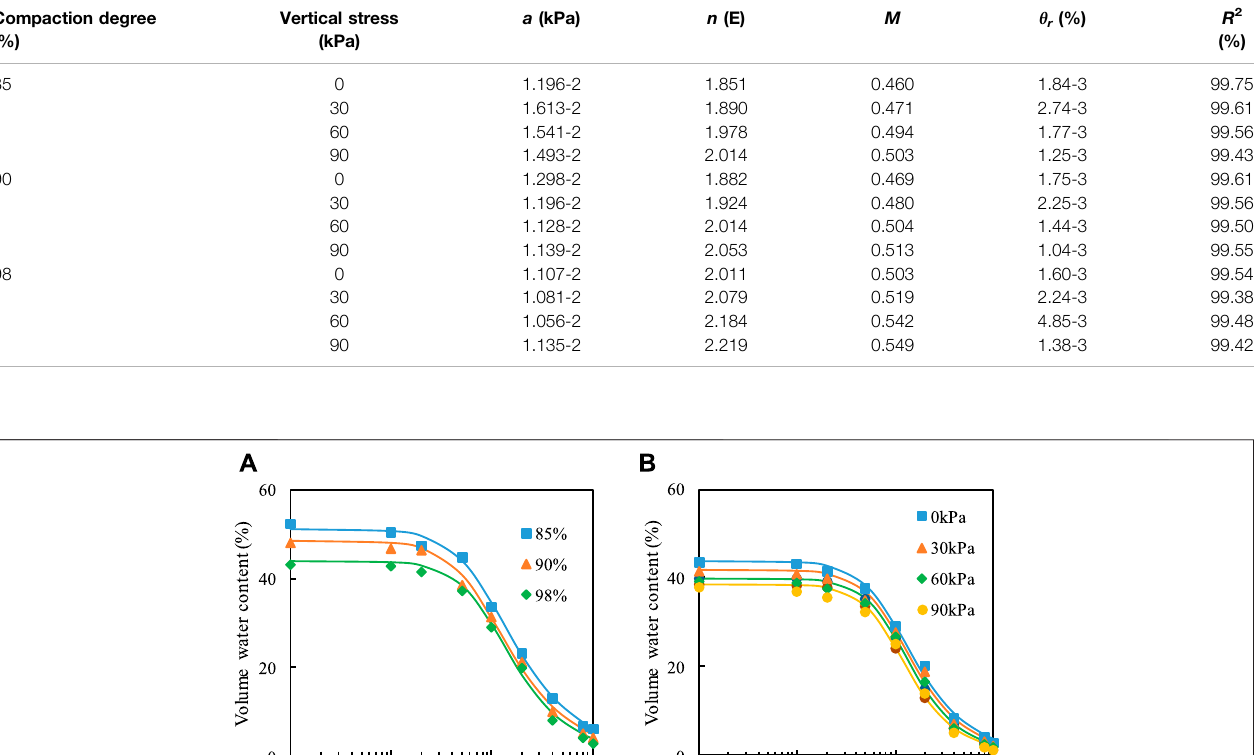
TABLE 5 | Fitting parameters for SWCC.